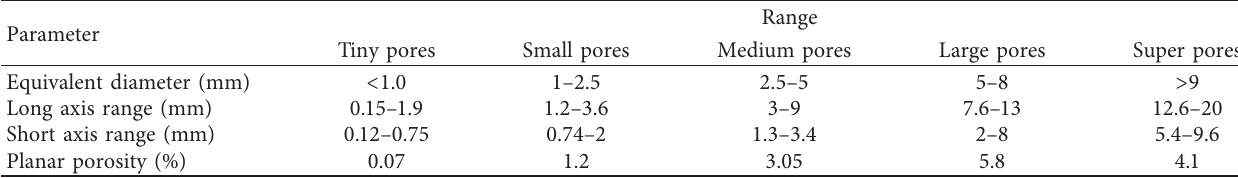
Table 5: Statistical results of pores feature for specimen 1#.